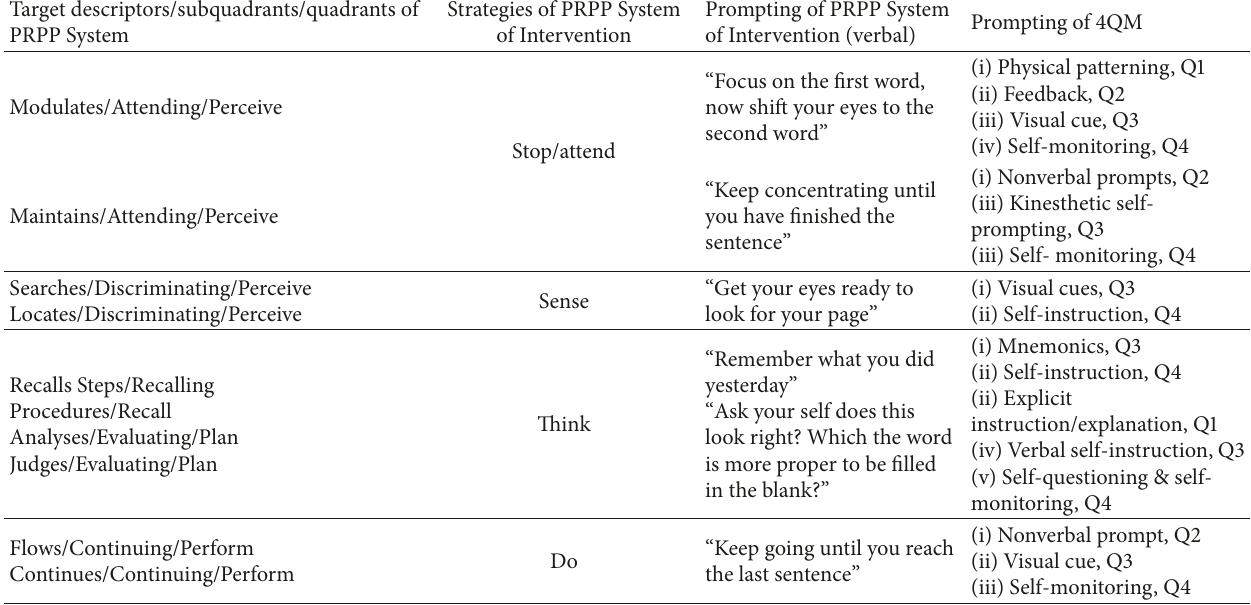
Table 2: The example of using the combination of the PRPP System of Intervention and the 4QM approach for academic activity (reading comprehension and written